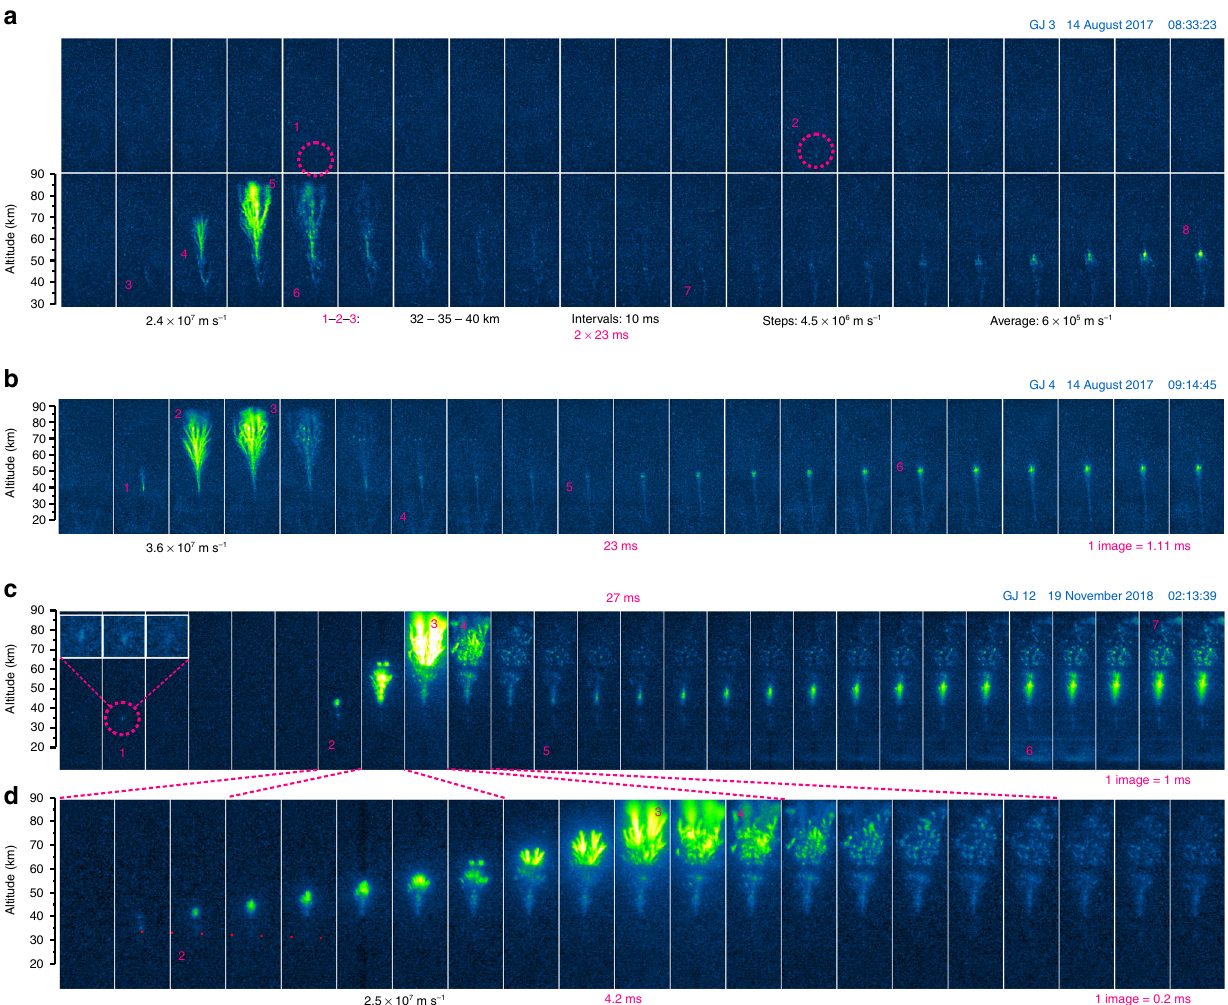
Fig. 2 Development of gigantic jets 3, 4, and 12 as recorded by the high speed camera. The selected image sequences focus on the upward development and the onset of the trailing jet in a GJ 3, b GJ 4, and c GJ 12 at ~1 ms resolution. Panel d is a zoom in time of the FDJ stage of GJ 12 with a temporal resolution of 0.2 ms. A dotted line indicates the brief downward extension of a streamer starting at the same time as the fi nal upward jump. An insert in panel c shows the step feature in 0.2 ms resolution. Numbered features are described in the text. The images had their background sky gradient subtracted, but in b transient V-shaped patterns caused by a human light source near the image bottom remain